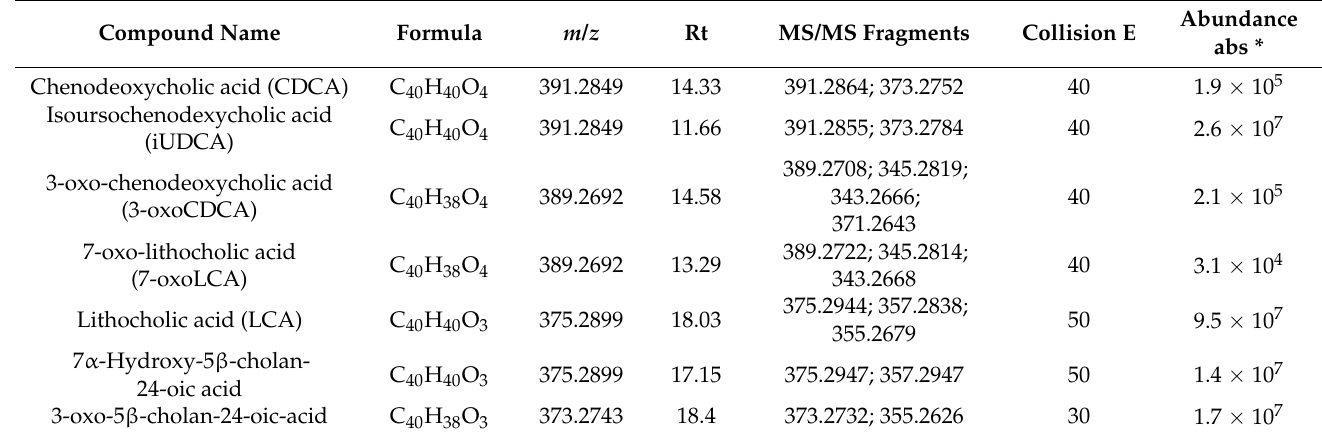
Table 1. BAs identified and confirmed of classical conversion trend of secondary